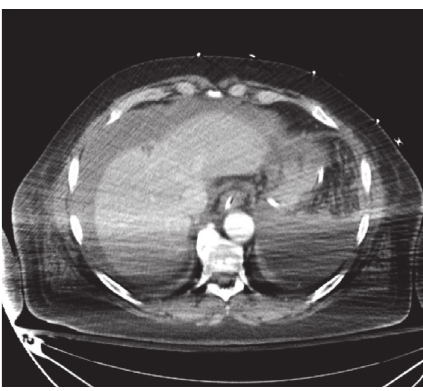
Figure 1: CT scan of abdomen and pelvic revealing hemoperitone- um and mass-like lesion in segment 4 of liver.